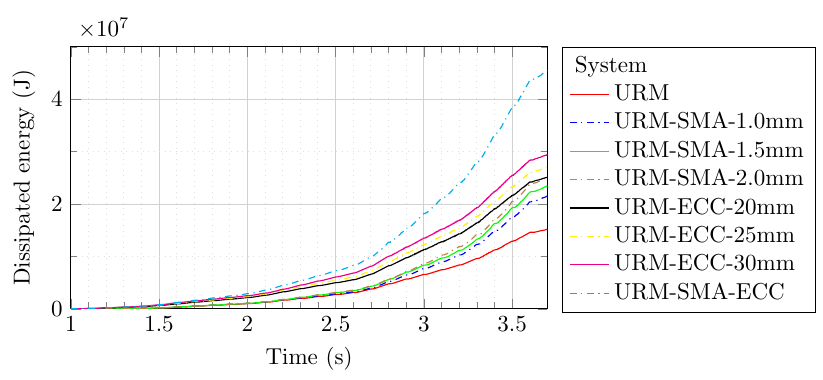
Figure 26. Energy dissipation of different models under cyclic